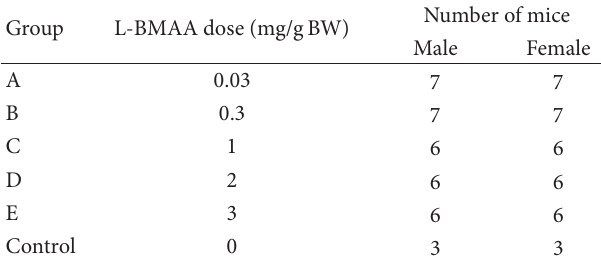
Table 1: L-BMAA doses and study design. BW: body